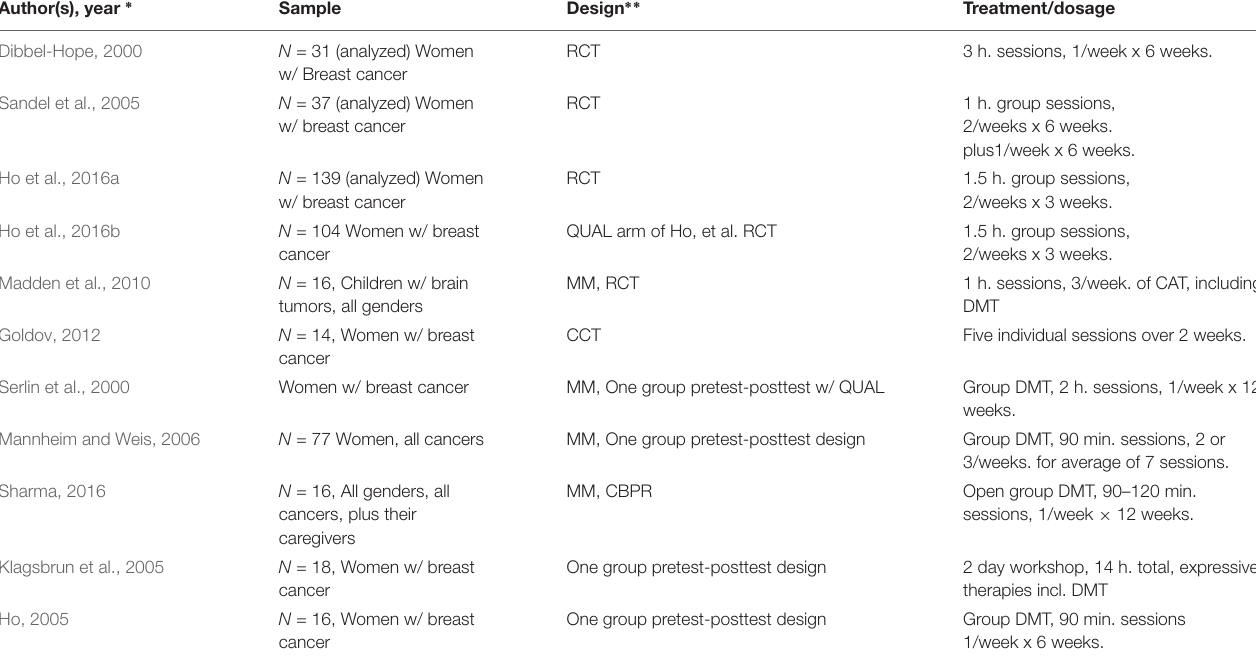
TABLE 1 | Features of several DMT studies in cancer